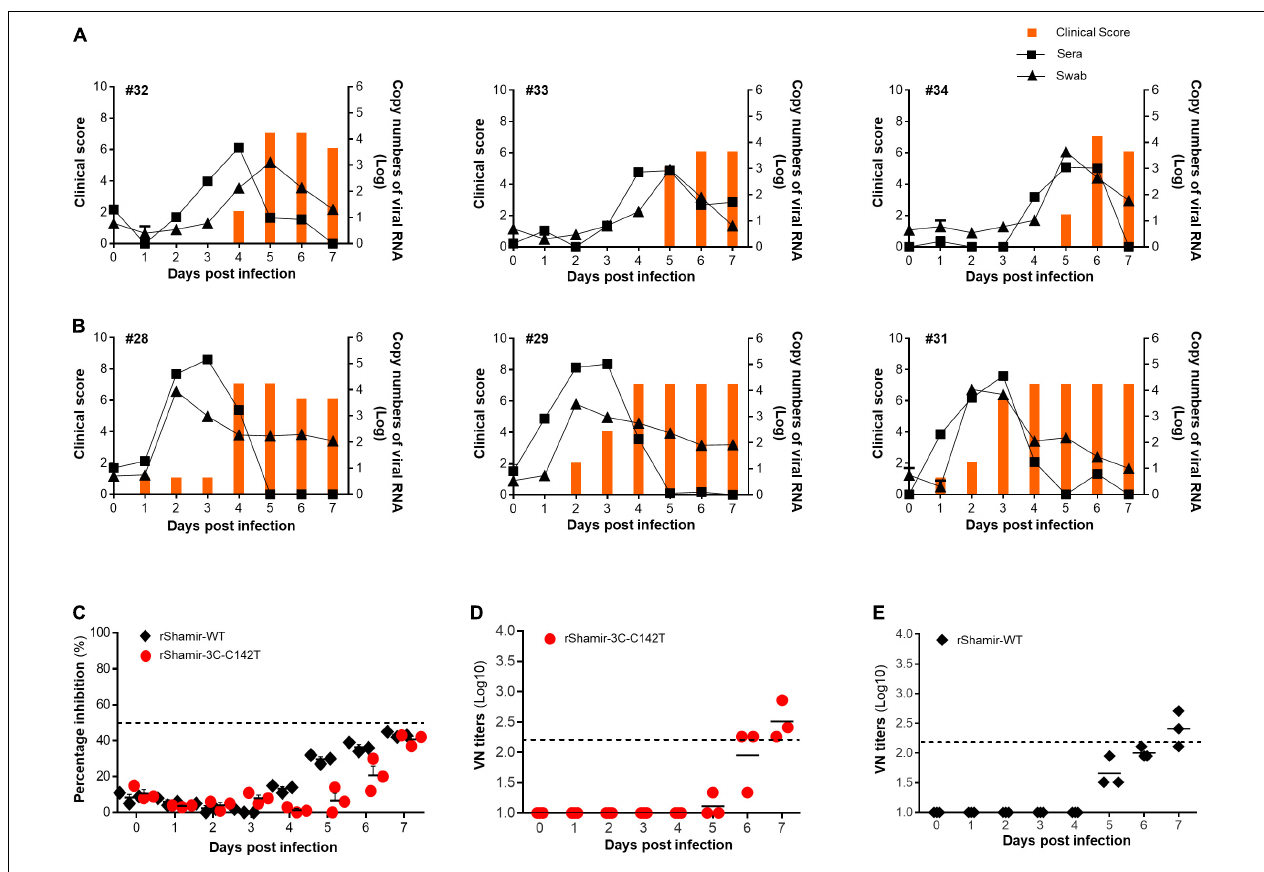
FIGURE 6 | Pathogenesis of the recombinant viruses in pigs. The experiment was carried out with six pigs which were divided into two groups ( n = 3). (A) One group was infected with rShamir-3C-C142T (animals #32, #33, and #34) and the (B) other group was infected with rShamir-WT (animals #28, #29, and #31), intradermally at a concentration of 1 × 10 3 . 0 TCID 50 /0.1 mL. The right Y-axis of the graph shows the amount of virus in sera and swab as log10 values and the left Y-axis shows the clinical index. (C) percentage inhibition and (D,E) virus-neutralizing titer of each recombinant FMDV infected animals in two groups were